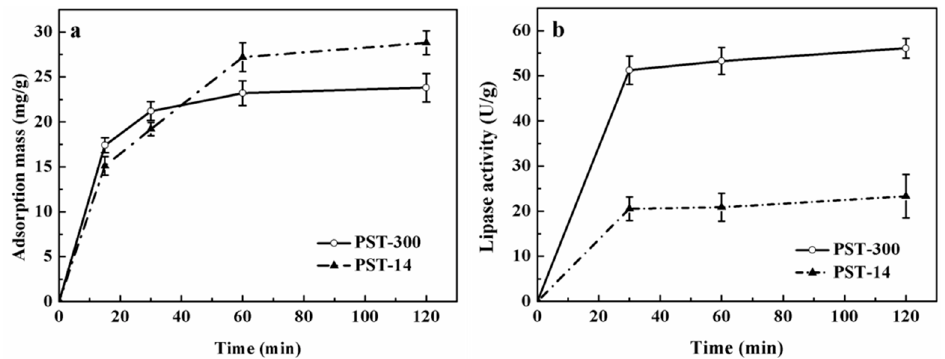
Figure 2. Adsorption process of lipase (0.05 mg/mL) in PST microspheres within 120 min (( a ) Adsorption mass; ( b ) Lipase activity).